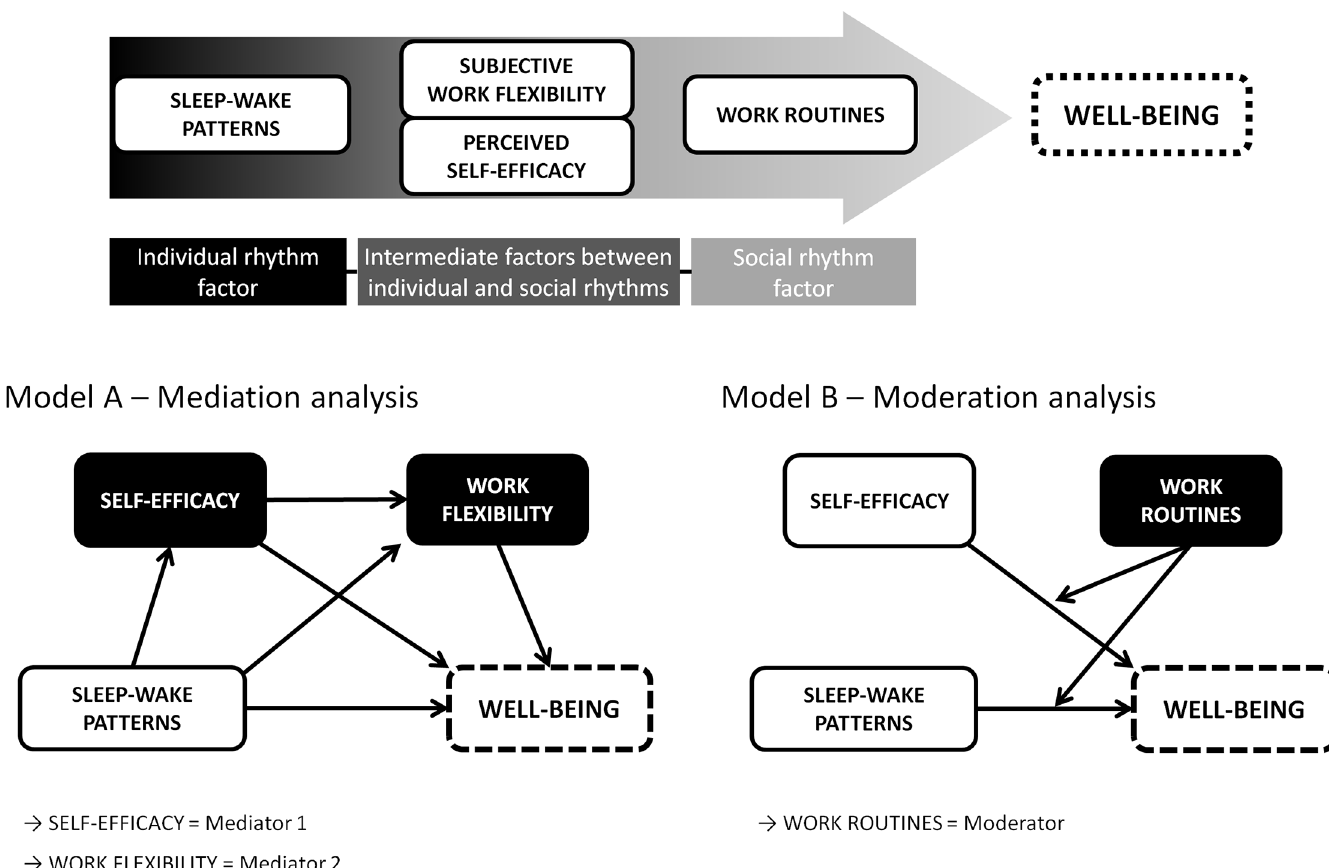
with sleep-wake patterns and perceived